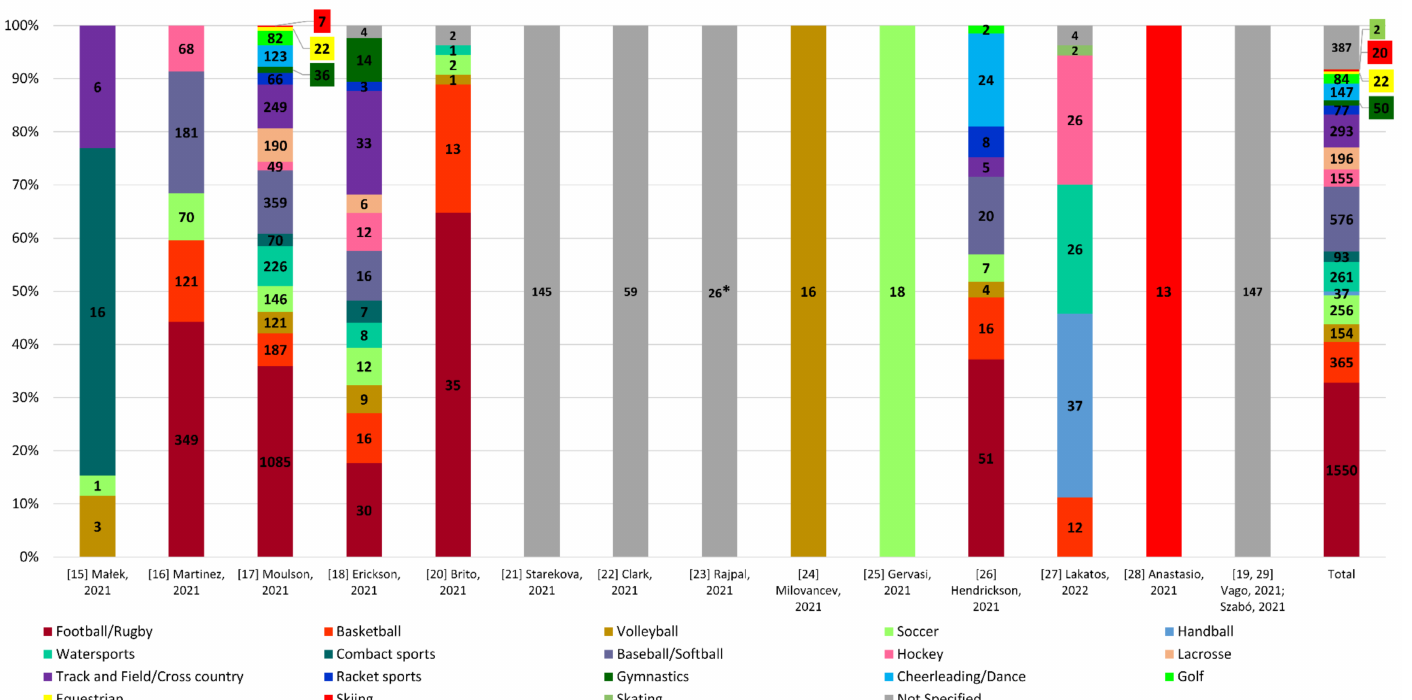
Figure 2. Column diagram of sport categories with counts and cumulative frequencies for each study and for the cumulative population of athletes. Some sport categories include two or more sport disciplines with similarities or common origins. Specifically, the football/rugby category includes football (1537) and rugby (13); the baseball/softball category includes baseball (479) and softball (97); the track-and-field/cross-country category includes track and field (n.a.) and cross country (n.a.); the racket sports category includes tennis (67) and squash (10); the watersports category includes swimming/diving (158), crew (54), water polo (37), sailing (10) and synchronized swimming (2); the combat sports category includes wrestling (77), fencing (15) and judo (1); finally, the cheerleading/dance category includes cheerleading (n.a.) and dance (n.a.). Study [29] includes the 12 athletes of study [19]. ‘*’ means that counts were not provided in the study and are consequently considered as not specified in the